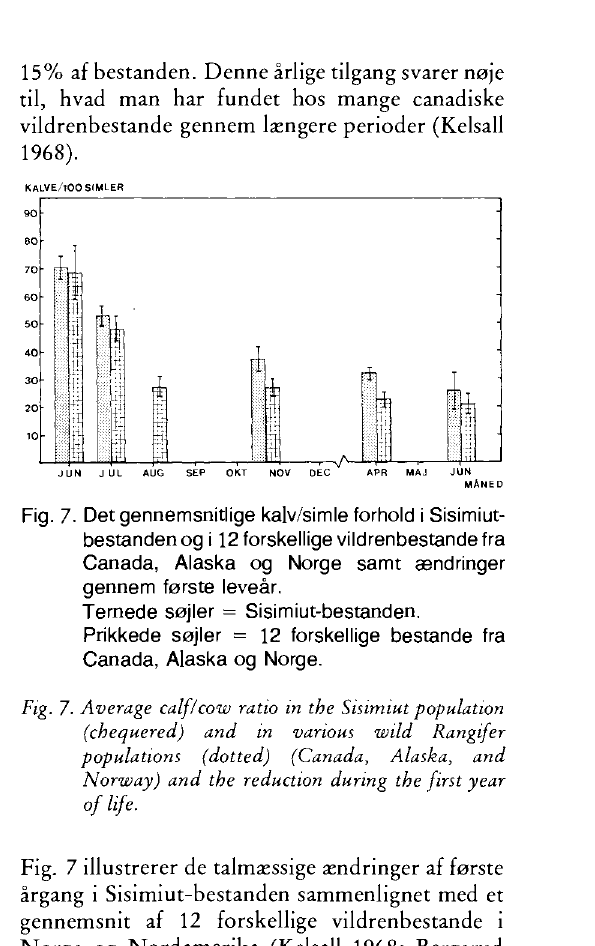
Fig. 7 illustrerer de talmæssige ændringer af første årgang i Sisimiut-bestanden sammenlignet med et gennemsnit af 12 forskellige vildrenbestande i Norge og Nordamerika (Kelsall 1968; Bergerud 1971; Parker 1972; Thomson 1977; Doerr 1979; Calef & Heard 1980; Davis m.fl.